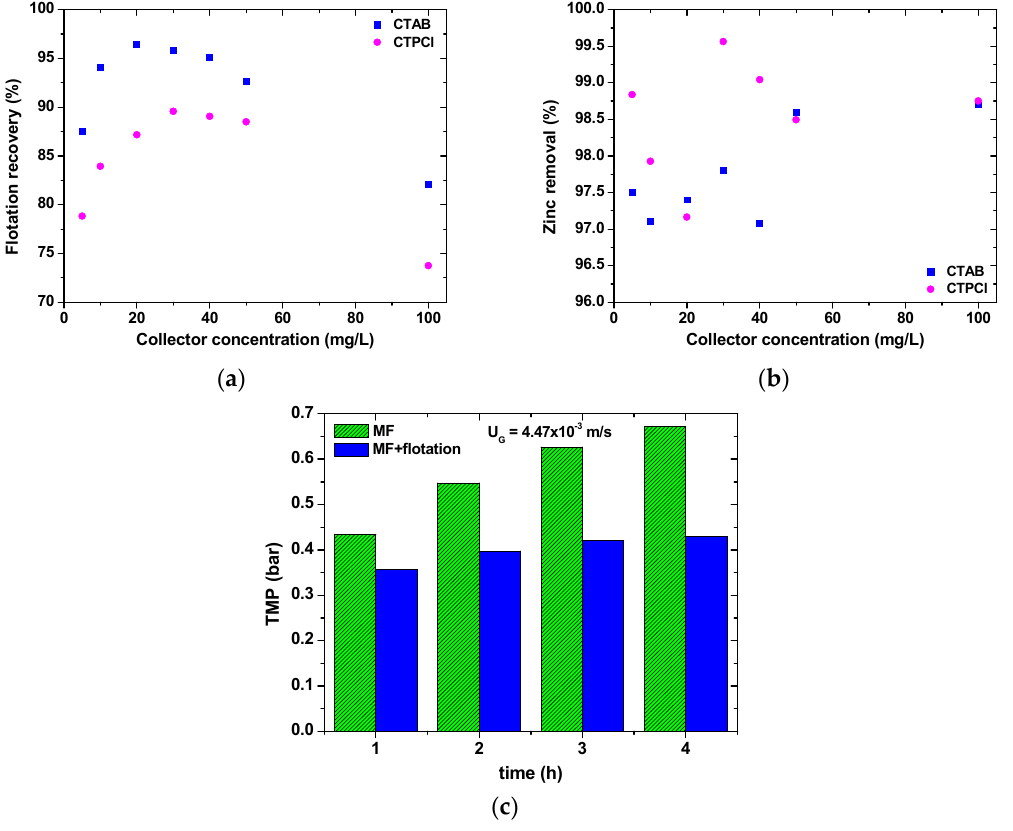
Figure 5. Batch flotation experiments using a brewery yeast Saccharomyces : ( a ) Effect of type and concentration of collector on flotation recovery; and ( b ) removal of zinc ions with 2 g/L yeast; [Zn 2+ ] = 50 mg/L, [zetag 63] = 2 mg/L, sorption time = 10 min, conditioning time = 10 min, flotation time = 3 min, air flow rate = 160 cc/min, pH = 6–6.5; and ( c ) improvement of hybrid flotation—microfiltration (MF) system operation as compared with simple MF system with air sparging. Reprinted with permission; copyright Taylor & Francis [51].